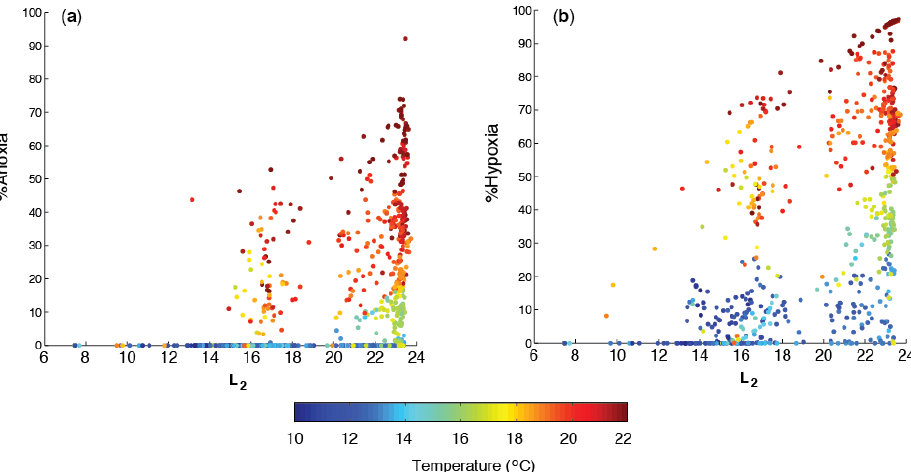
Fig. 9. Comparison of L 2 (extent of salinity intrusion) and (a) % Anoxia (DO bottom < 2mgL − 1 ) and (b) % Hypoxia (DO bot- tom < 4mgL − 1 ) against bottom water